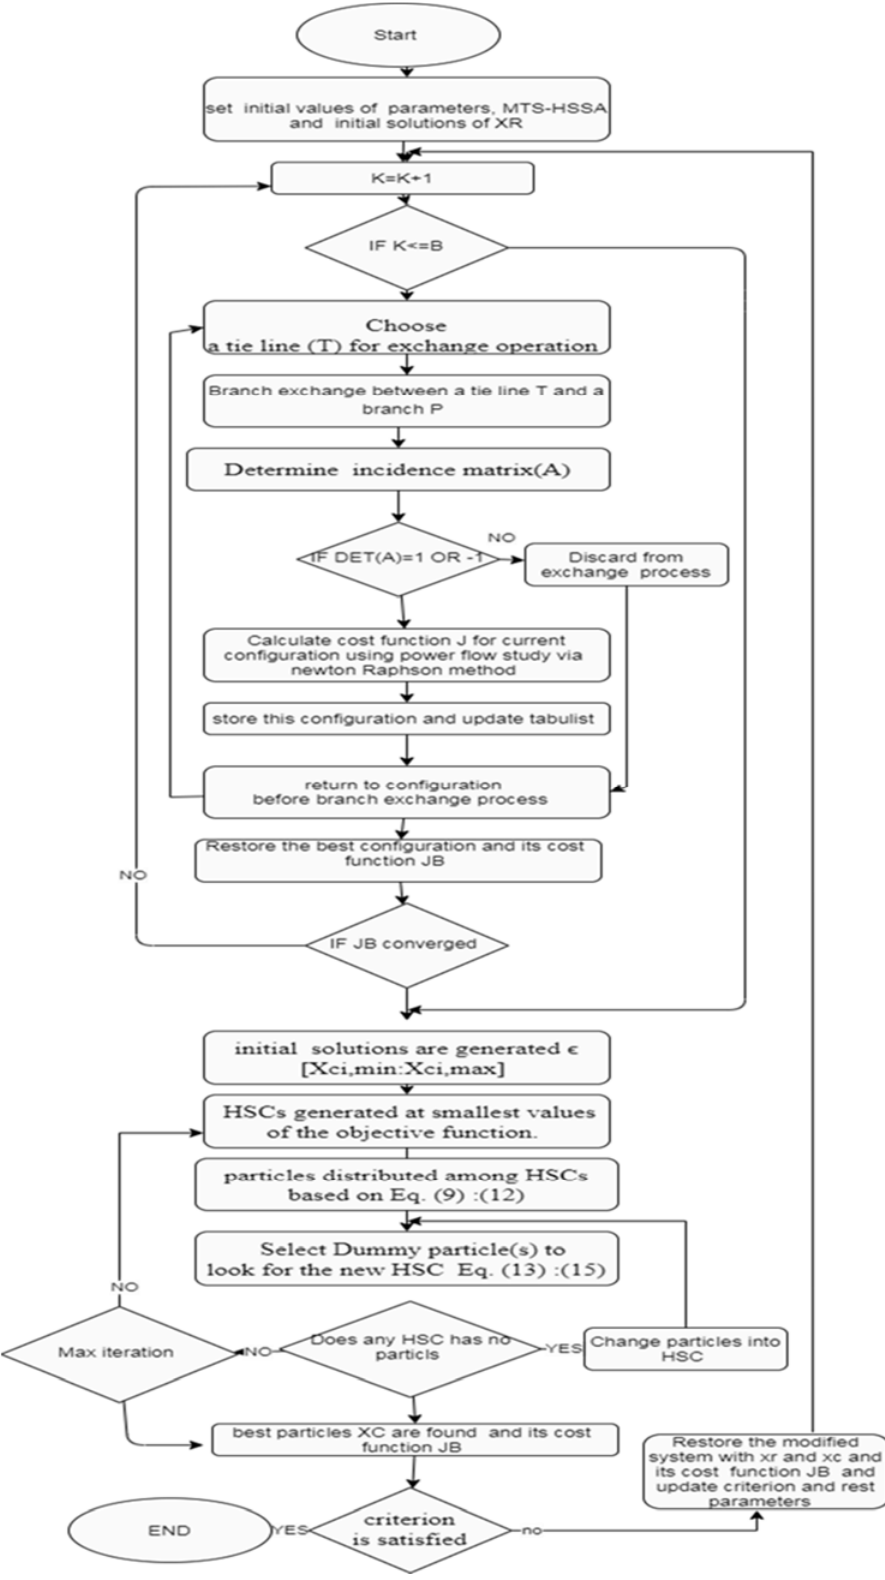
Figure 1. MTS ‐ HSSA flow chart. Figure 1. MTS-HSSA flow